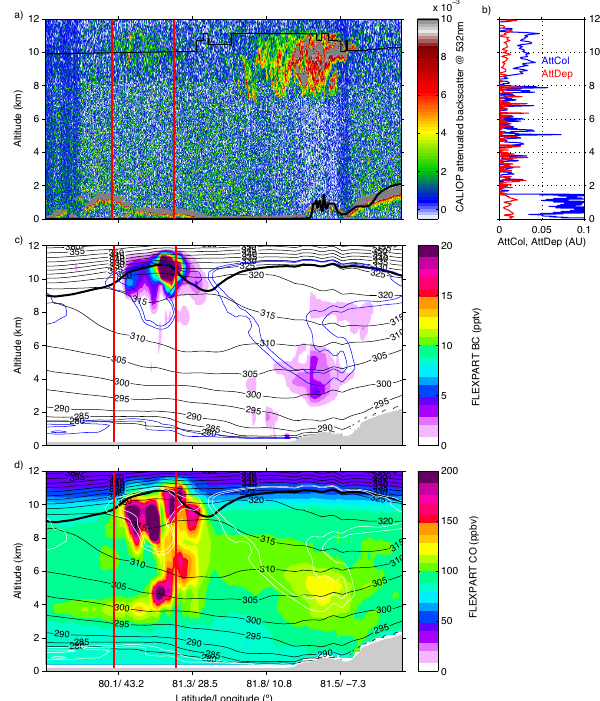
Fig. 9. Comparison of simulation data with the space-borne CALIPSO lidar for an aerosol feature observed on 5 July 2008 07:00UTC near Greenland (see Fig. 2d). (a) Aerosol backscatter and depolarization from the CALIPSO satellite and vertical mean for the feature delineated by red vertical lines, (b) Mean profiles of attenuated color ratio (blue, AttCol) and attenuated depolariza- tion (red, AttDep) in arbitrary units averaged over the segment marked by red lines in panel (a) , (c) FLEXPART black carbon tracer concentration (pptv), (d) CO concentration (ppbv) from FLEX- PART. Meteorological conditions are indicated by the dynamical tropopause (2pvu, thick black and white contour), potential tem- perature (thin black contours), and relative humidity (80% and 90%, blue and white contours) from ECMWF analyses. Red lines indi- cate the location of the aerosol